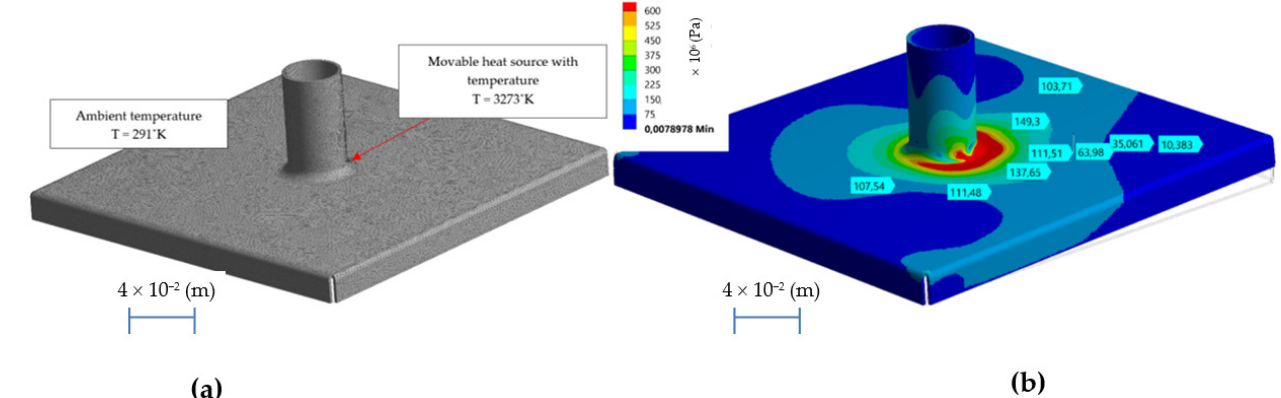
Figure 5. Discrete model of a test sample with added initial and boundary conditions ( a ), the state of effective stress after the welding process ( b ).